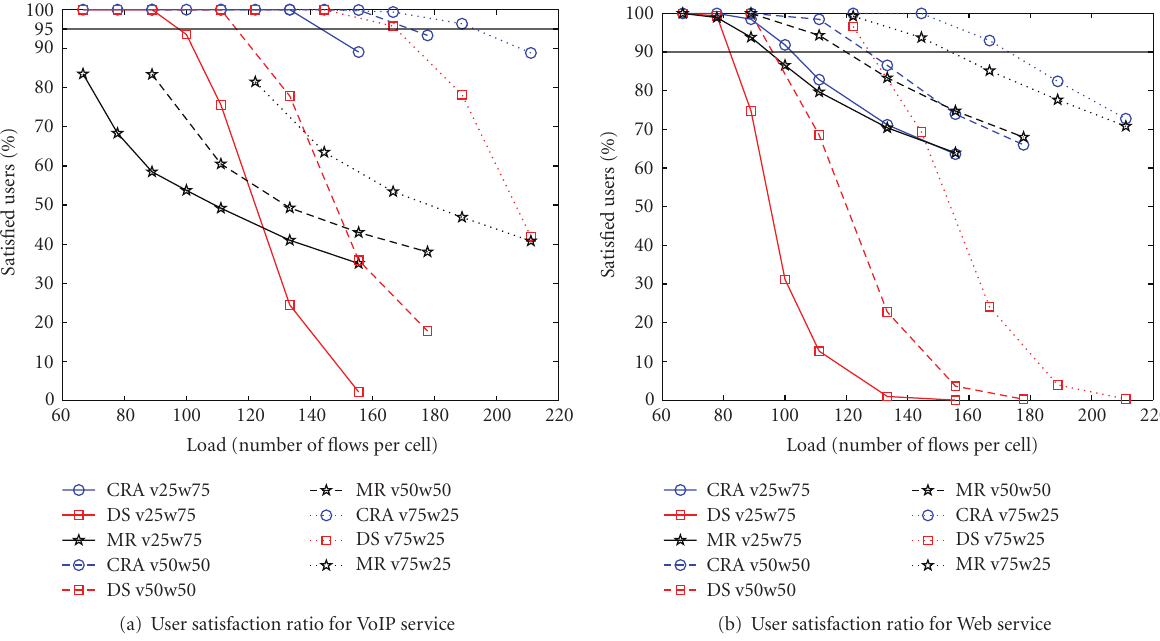
Figure 7: User satisfaction ratio in the mixed service scenarios 25% VoIP and 75% Web, 50% VoIP and 50% Web and 75% VoIP and 25% Web for CRA, DS and MR